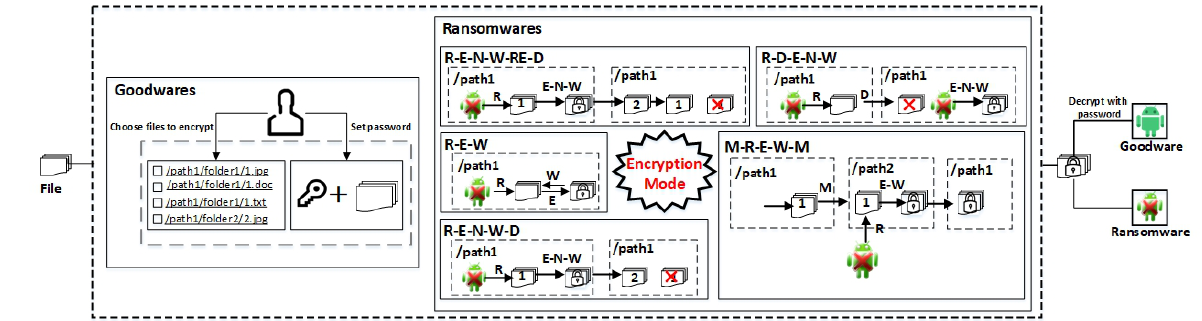
Figure 3. Differences between files encryption ransomware and goodware